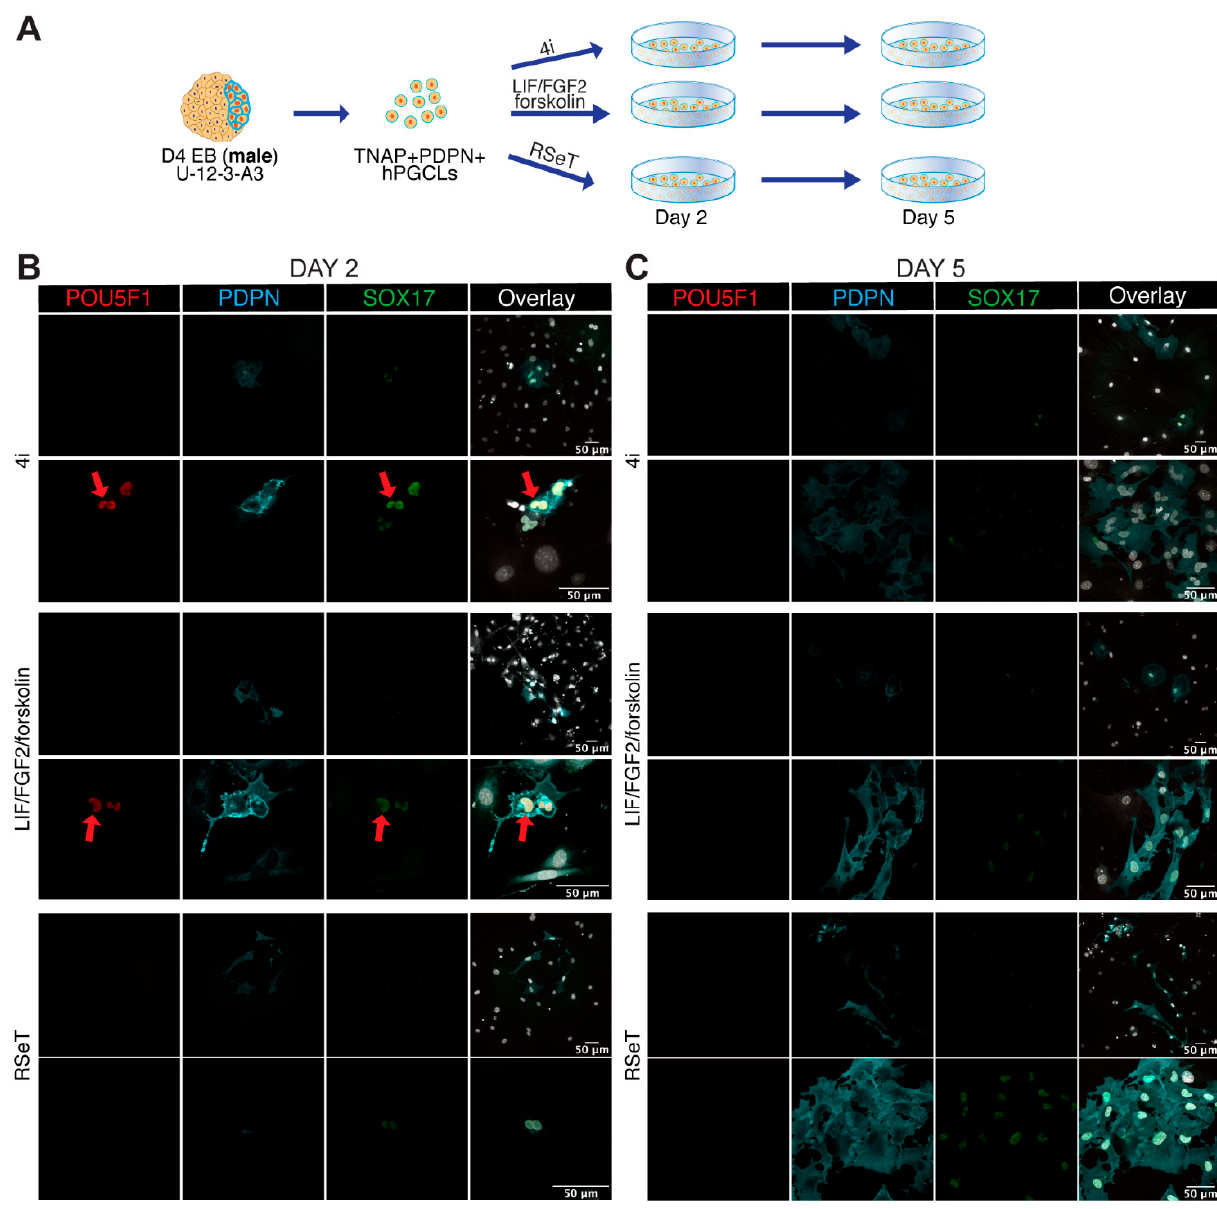
Figure 3. Evaluating the propagation of male hPGCLCs in vitro. ( A ) Scheme showing the extended culture protocol used of (male) TNAP+PDPN+ hPGCLCs FACS-isolated from D4 EBs and cultured in different media (4i, RSeT and LIF/FGF2/forskolin). ( B ) Images from day 2 of extended culture of male hPGCLCs in different media (4i, RSeT and LIF/FGF2/forskolin) immunostained for POU5F1, SOX17 and PDPN. Red arrows point to POU5F1+SOX17+PDPN+ hPGCLCs. Scale bars are 50 μ m. ( C ) Images from day 5 of extended culture of male hPGCLCs in different media (4i, RSeT and LIF/FGF2/forskolin) immunostained for POU5F1, SOX17 and PDPN. Scale bars are 50 μ m.